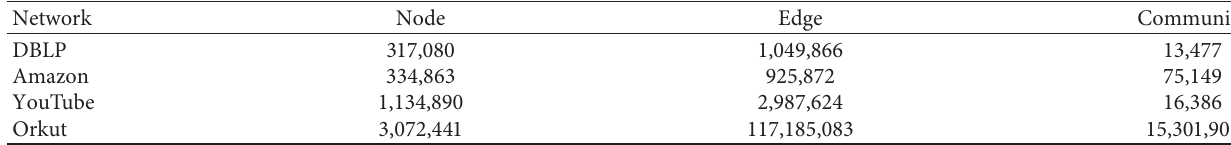
Figure 9: Experimental results on the synthetic network (N1, N2, N3, N4). Table 2: Characteristics of the test network.